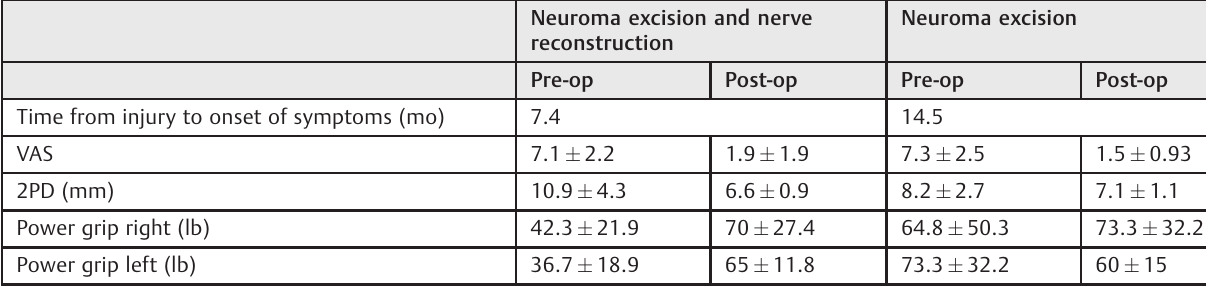
Neuroma excision